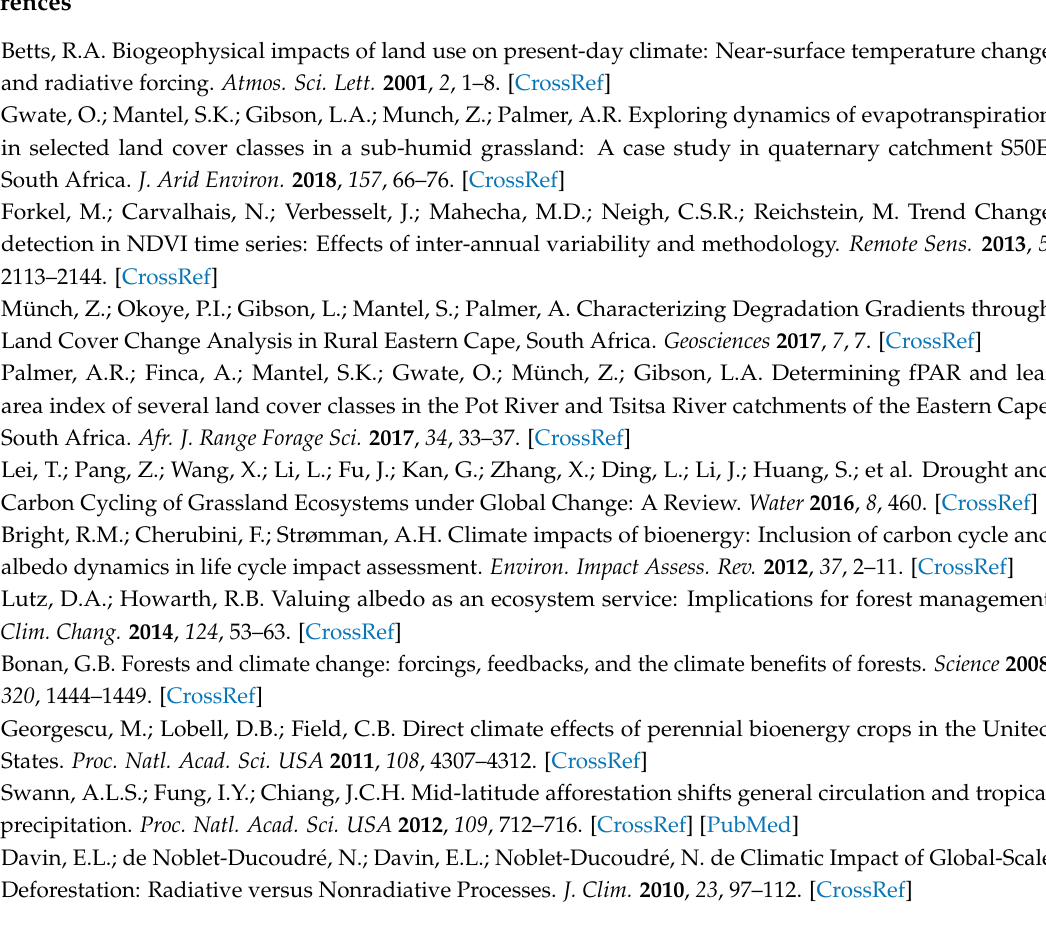
Table S1: Correlation coefficients per land cover class and transition, Table S2: Total and significant change in PSA per catchment T35B, reported in percentage area and PSA change (highlighted in light grey), Table S3: Total and significant change in PSA per catchment S50E, reported in percentage area and PSA change (highlighted in light